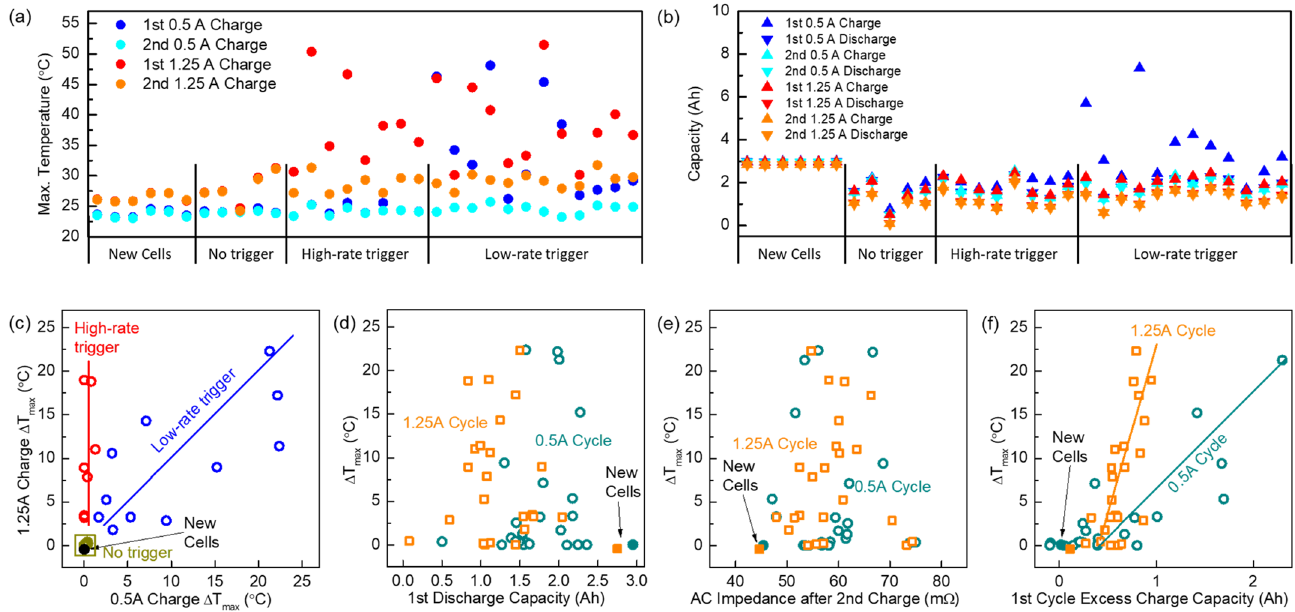
Figure 2. The capacity and difference of maximum charge temperature between the first and second cycle ( Δ T max ) at different rates for new and recycled cells. ( a ) Maximum charge temperature of new and recycled cells during the initial screening tests. ( b ) Charge and discharge capacities of new and recycled cells during the initial screening tests. ( c ) Δ T max in 1.25 A cycles vs. Δ T max in 0.5 A cycles. ( d ) Δ T max in both 1.25 A and 0.5 A cycles vs. the corresponding discharge capacity in the first cycle. ( e ) Δ T max in both 1.25 A and 0.5 A cycles vs. the corresponding 1 kHz AC impedance measured at the end of second charge process. ( f ) Δ T max in both 1.25 A and 0.5 A cycles vs. the corresponding excess charge capacity in the first cycle (the difference between the 1st 1.25 A or 0.5 A cycle charge capacity and the 2nd 0.5 A cycle charge capacity). The data of the new cells are shown as solid points, while the data of the recycled cells are shown as open points.